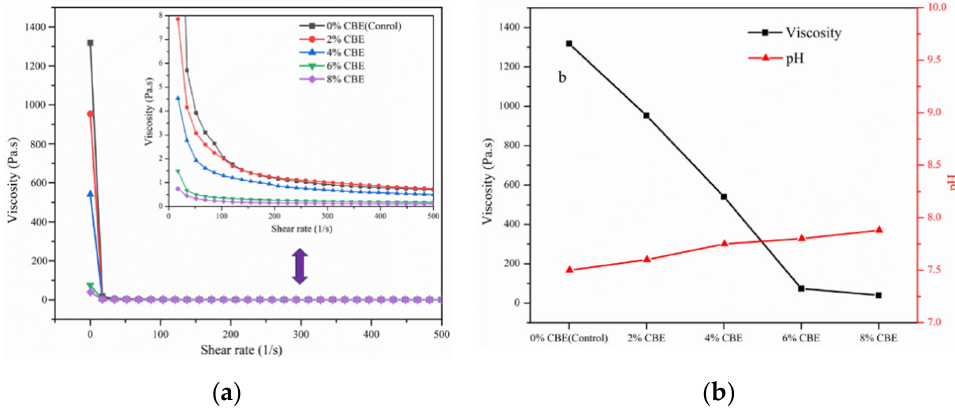
Figure 7. Rheological curves ( a ), initial viscosity and pH ( b ) of soybean protein ‐ based adhesive with different CBE content.